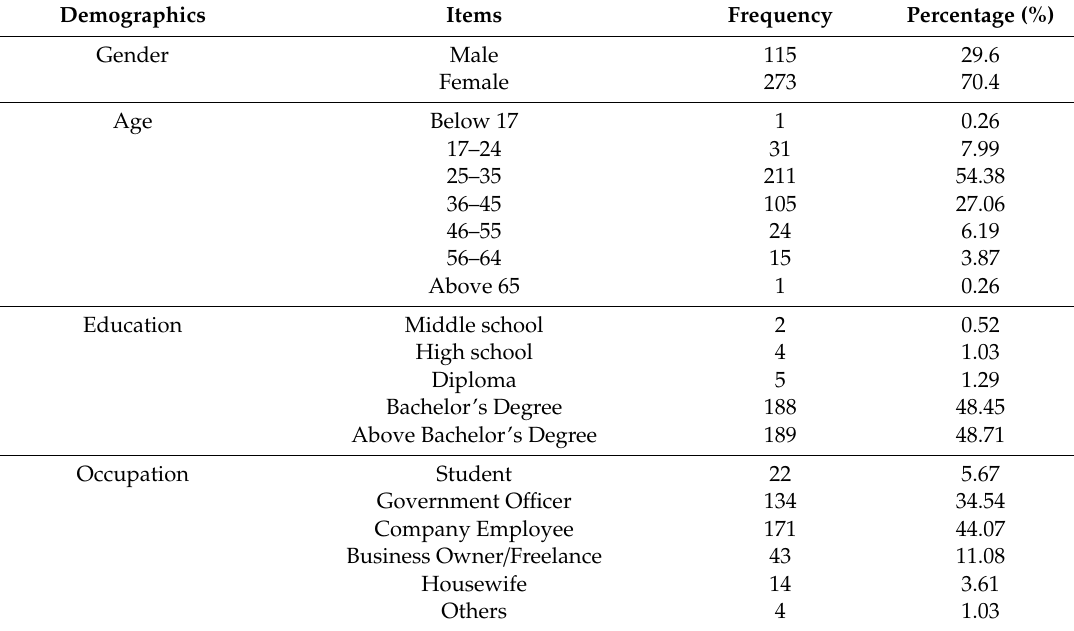
Table 1. Demographic characteristic of the